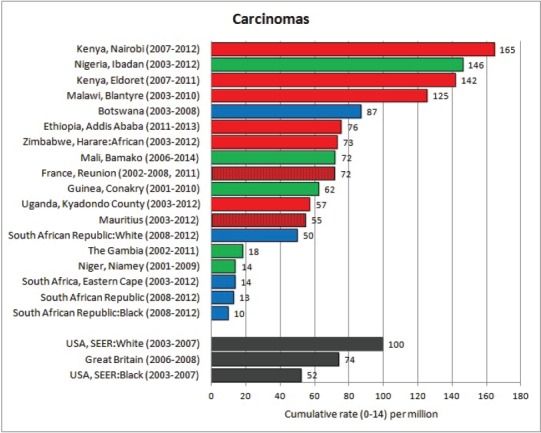
Cumulative (0–14) incidence rate—carcinomas.